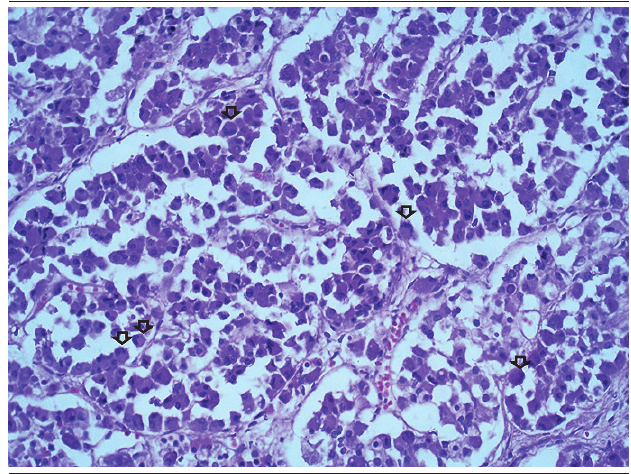
figurE 8 − Histological section of pituitary adenoma with cells of eccentric indented nucleus (arrows) HE 200× HE: hematoxylin and